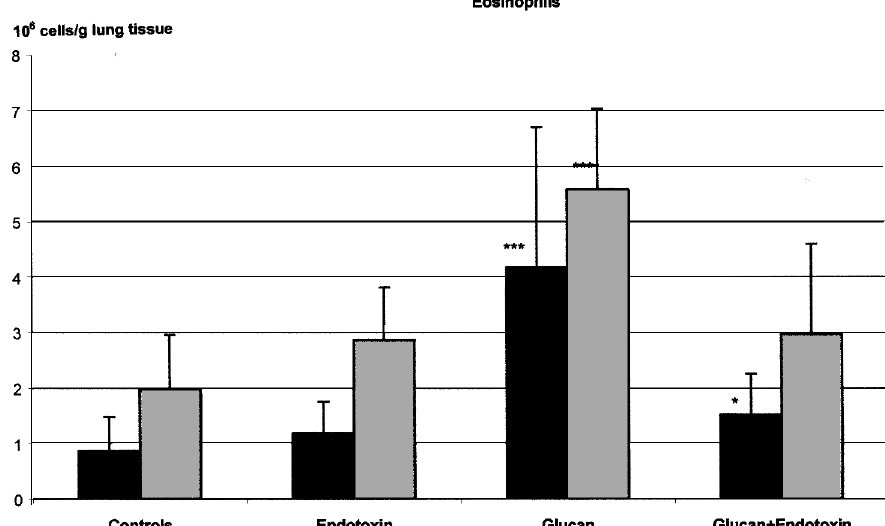
FIG. 4. The numbers of eosinophils in lung lavage fluid (black bars) and lung interstitium (grey bars). The results are presented as mean values with standard deviations. * p < 0.05, *** p < 0.001 as compared to